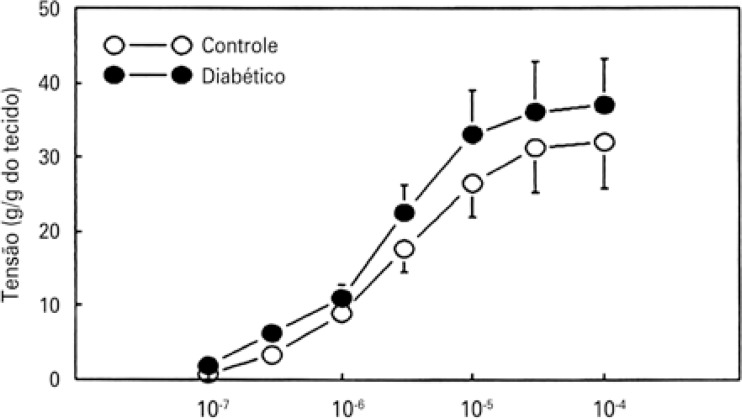
Curvas de concentração-resposta para o betanecol em tiras de bexiga isoladas de ratos controle (n=4) e ratos com diabetes induzido por aloxana (n=4)